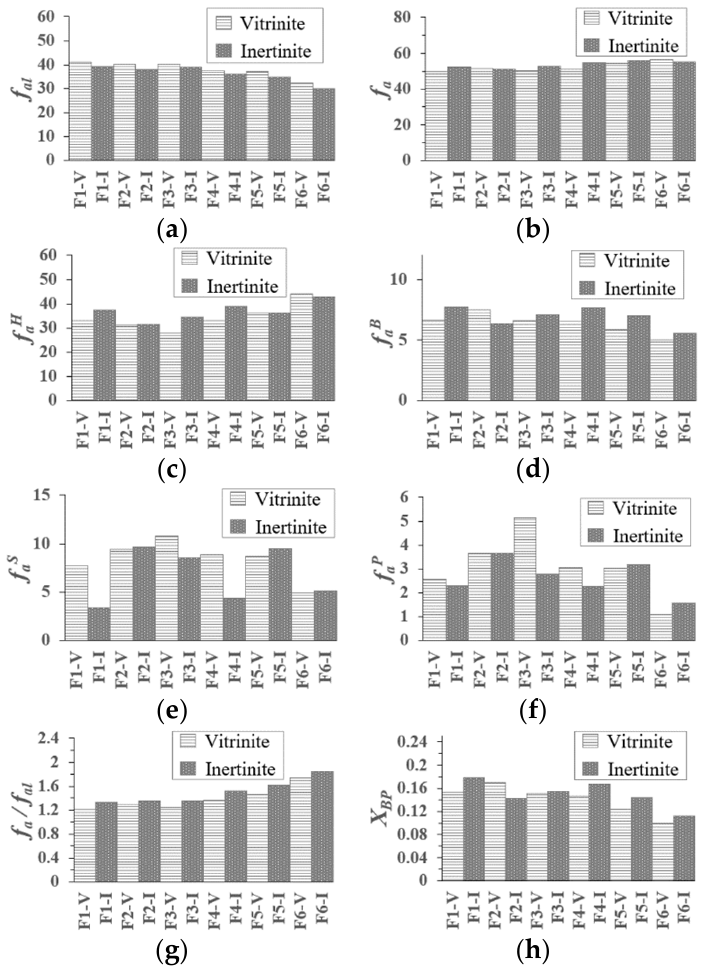
Figure 10. NMR structure parameters of samples (( a – h ) are the distributions of f al , f a , f aH , f aB , f aS , f aP , f a /f al , and X BP , respectively). f al is aliphatic carbons; f a is aromatic carbons; f aH is protonated aromatic carbons; f aB is aromatic bridgehead carbons; f aS is alkylation aromatic carbons; f aP is non-protonated aromatic carbon constituted by phenolic; and X BP is the ratio of aromatic bridge carbon to aromatic peripheral